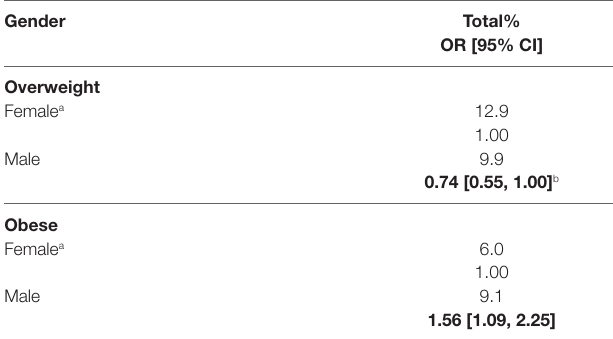
Boldface indicates a significant difference between groups after post hoc correction for multiple comparisons. SES, socioeconomic status; OR, odds ratio; CI, confidence interval. a Reference group for comparisons between SES strata. TaBle 4 | Comparison of overweight and obesity prevalence by gender.